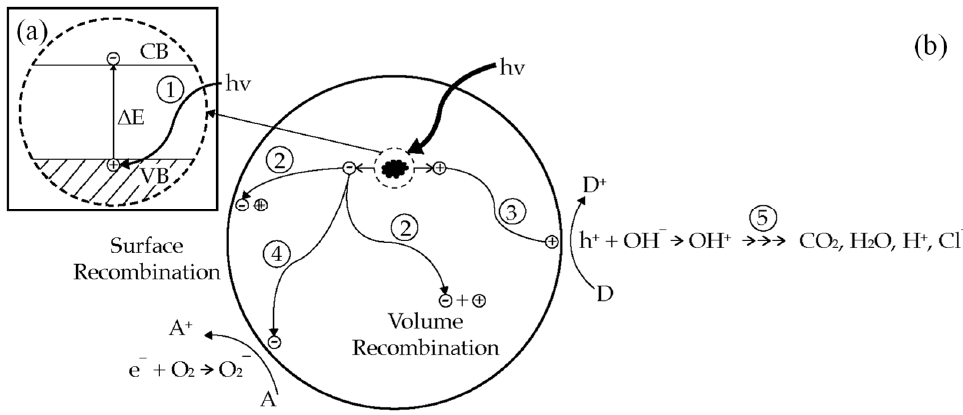
Figure 4. ( a ) Photoexcitation process; ( b ) Primary steps in photocatalytic mechanism. In semiconductor, the valence band and the conduction band are separated by a bandgap ∆ E, a region devoid of energy in a perfect crystal as shown in the enlarged section of Figure 4a. The highest energy band containing electrons is called the valence band (VB); the lowest empty band is called the conduction band (CB) [26]. The energy difference be- tween the highest occupied band (the valence band), and the lowest unoccupied band (the conduction band) is called the bandgap, Δ E. By absorbing a photon energy equal to or greater than the band gap, Δ E, of the semiconductor, an electron is excited from the va- lence band into the conduction band, leaving behind a hole in the valence band (step 1), as shown in the enlarged section of Figure 4a [27]. The created electron-hole pair has a cies on the semiconductor surface [28]. In the absence of the adsorbate, the excited elec- trons at the conduction band and holes at the valence band can recombine (step 2) and dissipate the input energy as heat.